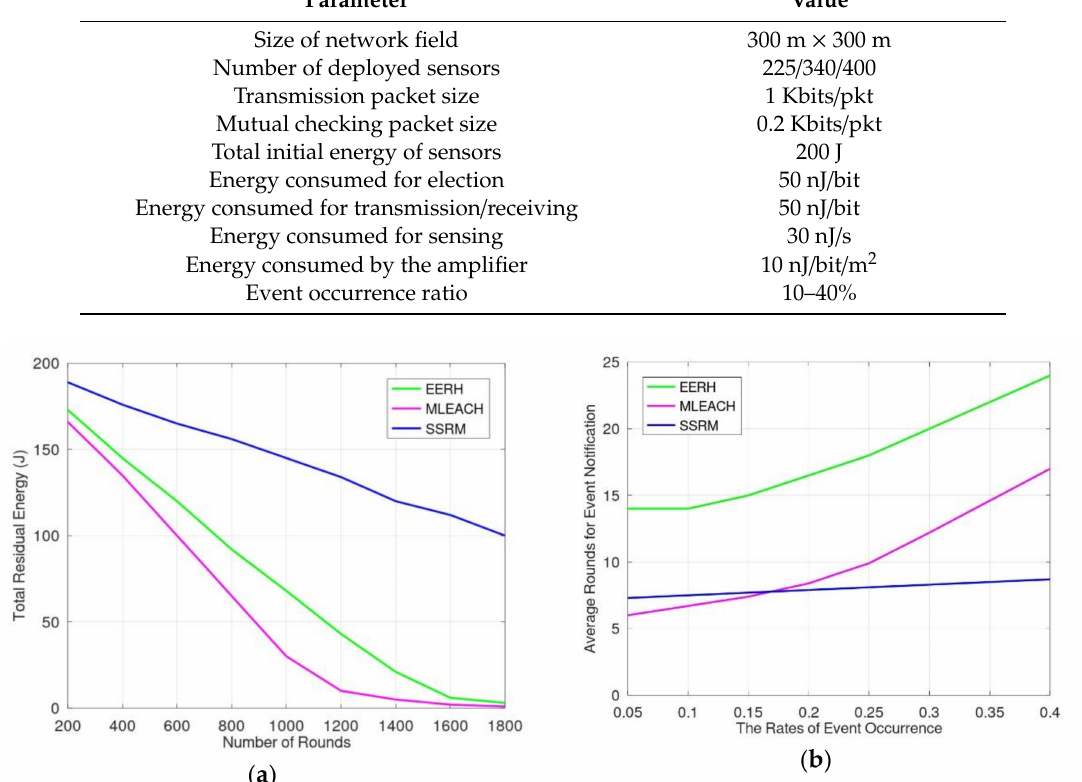
Figure 6. ( a ) Energy consumed by sensors according to monitoring time when the rate of event occurrence is 10%; ( b ) average notification time for one